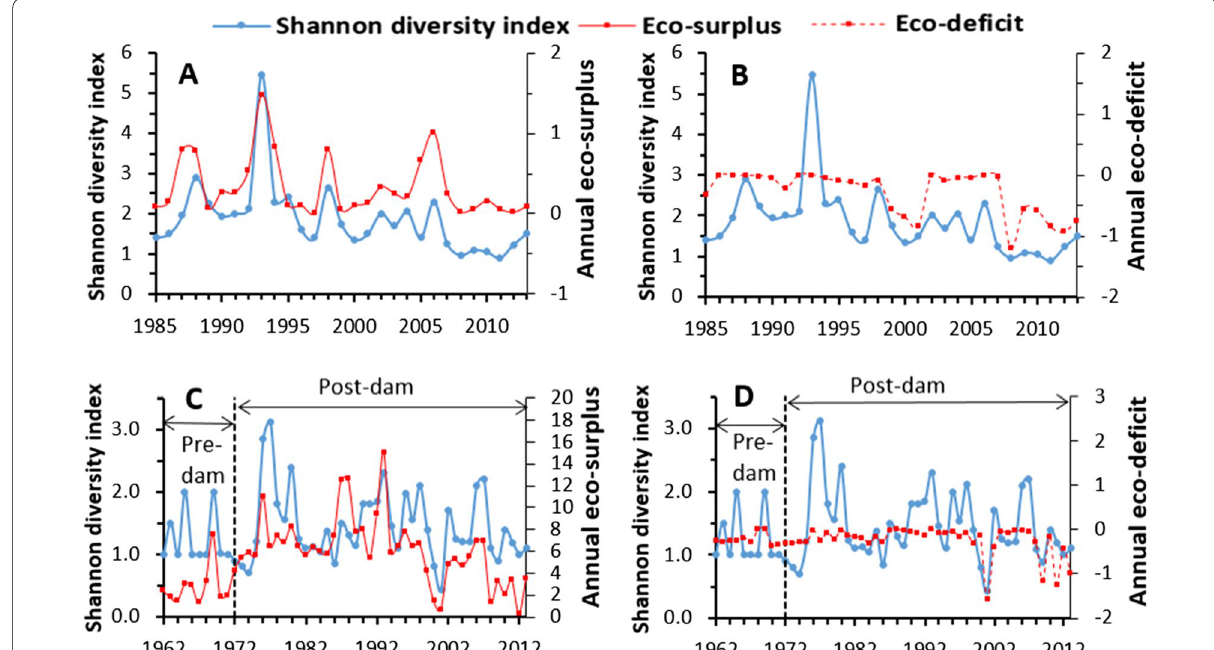
Fig. 6 The variation of modeled Shannon diversity index and annual eco-flows determined by discharge hydrographs in Qale-Shahrokh station ( A , B ) and Pole-Kalle station ( C , D